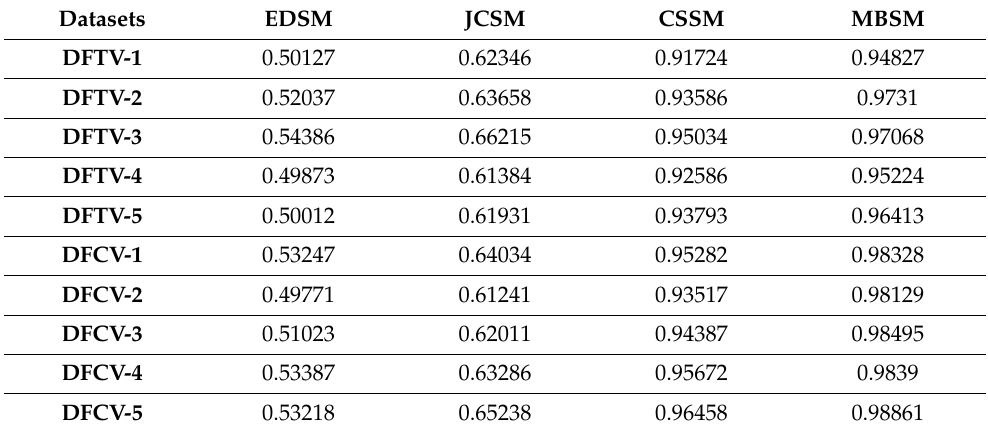
Table 3. Mean average precision @5 for DFTV and DFCV datasets using the Resnet-50 CNN model.